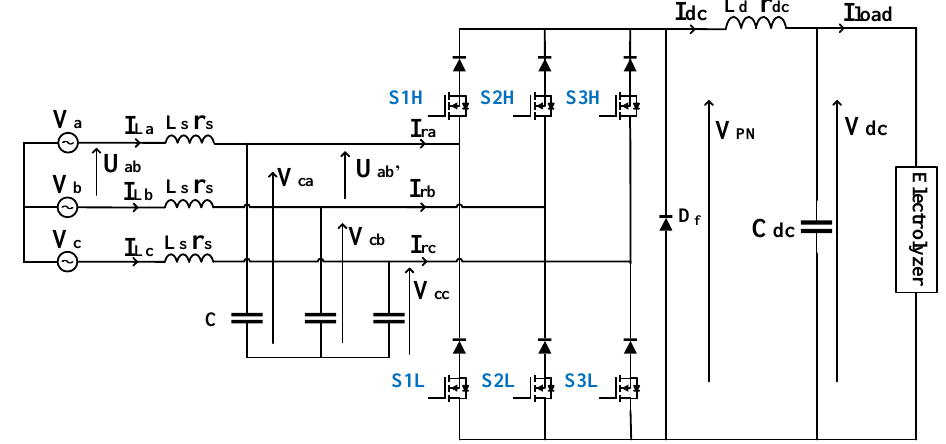
Figure 3. Buck-type current-source